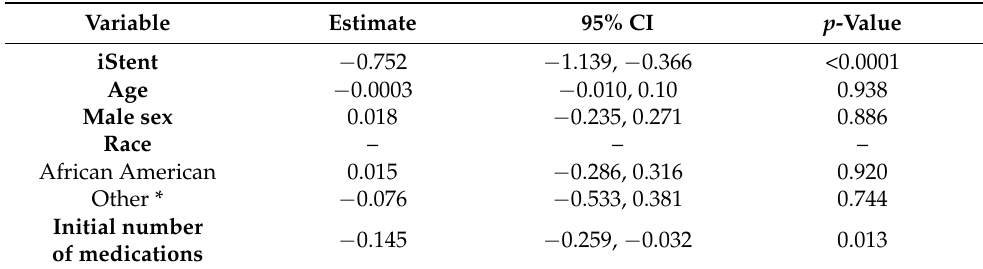
Table 4. Univariate analysis for association with number of medications 6 months post-SLT.